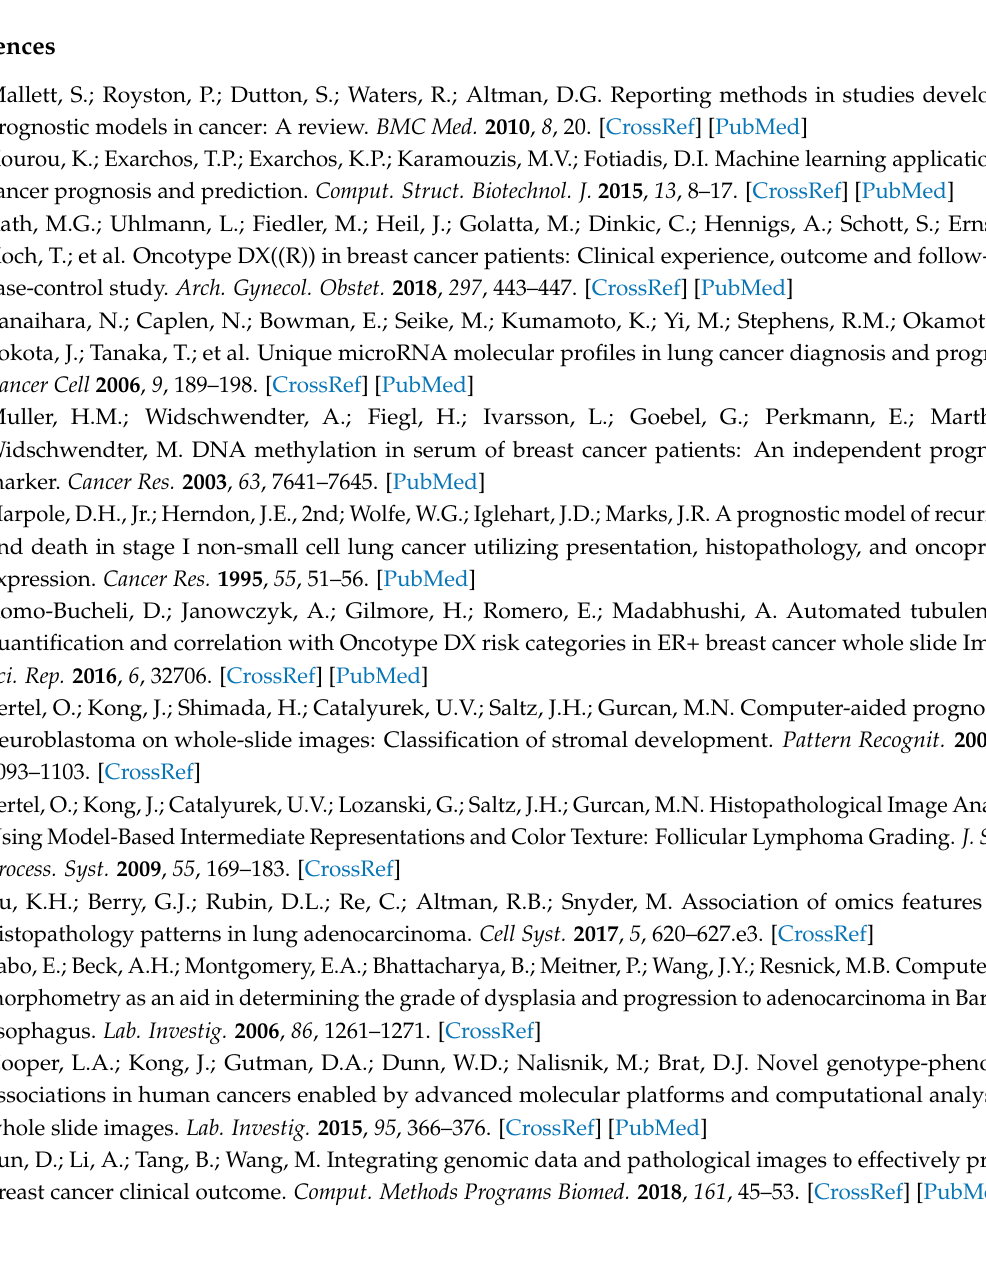
Table S1: Detailed estimation results referred to in Section 4, TestLDHD: R code and example